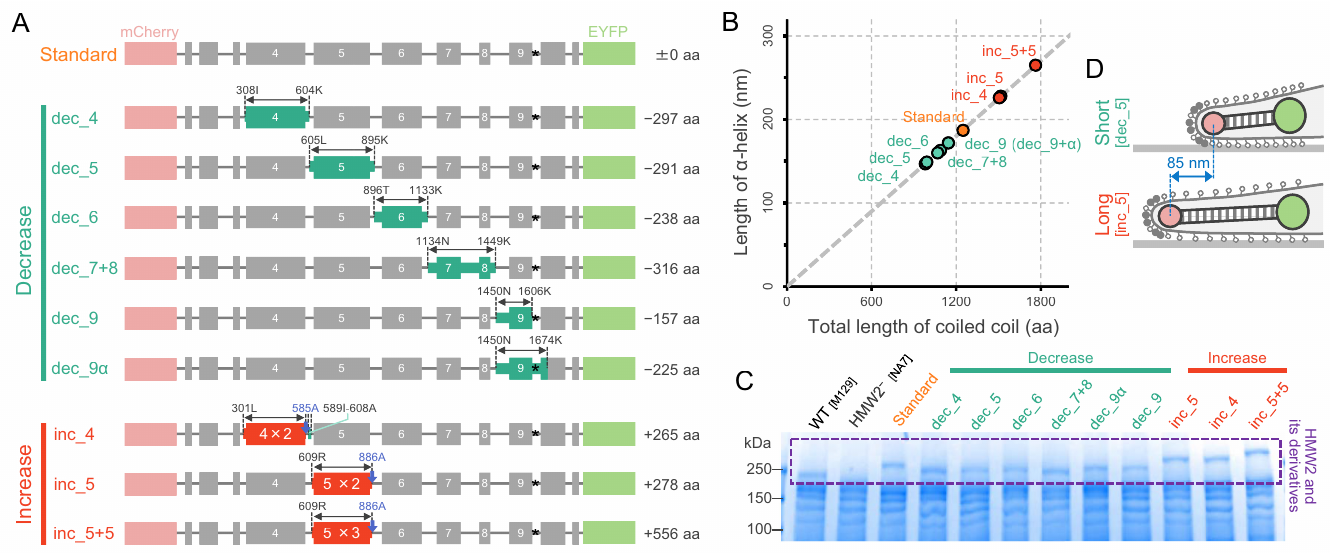
Fig 2. Engineering of HMW2. (A) Construction of the size-modified HMW2-derivatives. The decreased and increased parts are were in green and red, respectively. The difference of amino acids number was presented at the right. All derivatives were fused with mCherry and EYFP at the N- and C-termini, respectively, and have the codon substitution to disturb the internal translation of P28. (B) Length estimation of the size-modified HMW2-derivatives. The length of α -helix was calculated by the total amino acid numbers of predicted coiled-coil domains in each HMW2 derivative. (C) Protein profiles of WT and HMW2-derivative mutants. The entire cell lysate was subjected to SDS-PAGE, and stained by CBB. The molecular mass was shown on the left. The protein bands from hmw2 derivatives were shown in a dashed box (see also S1 Fig). (D) Schematics of the length-controlled attachment organelle in the size-modified HMW2-derivative mutants.